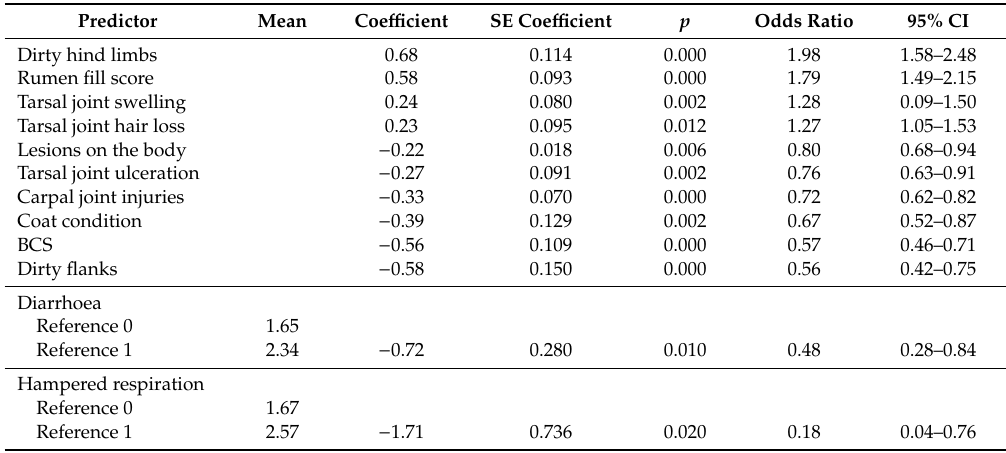
Table 4. Association of avoidance distance of shelter cows ( n = 1620) with animal-based parameters using ordinal logistic regression.